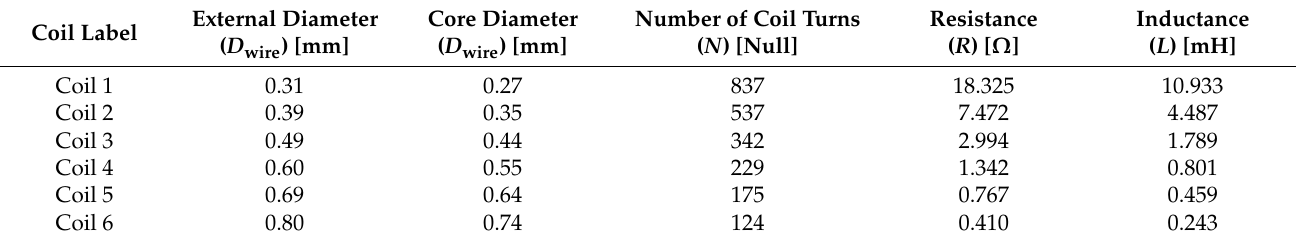
Table 1. The main parameters of the coils.